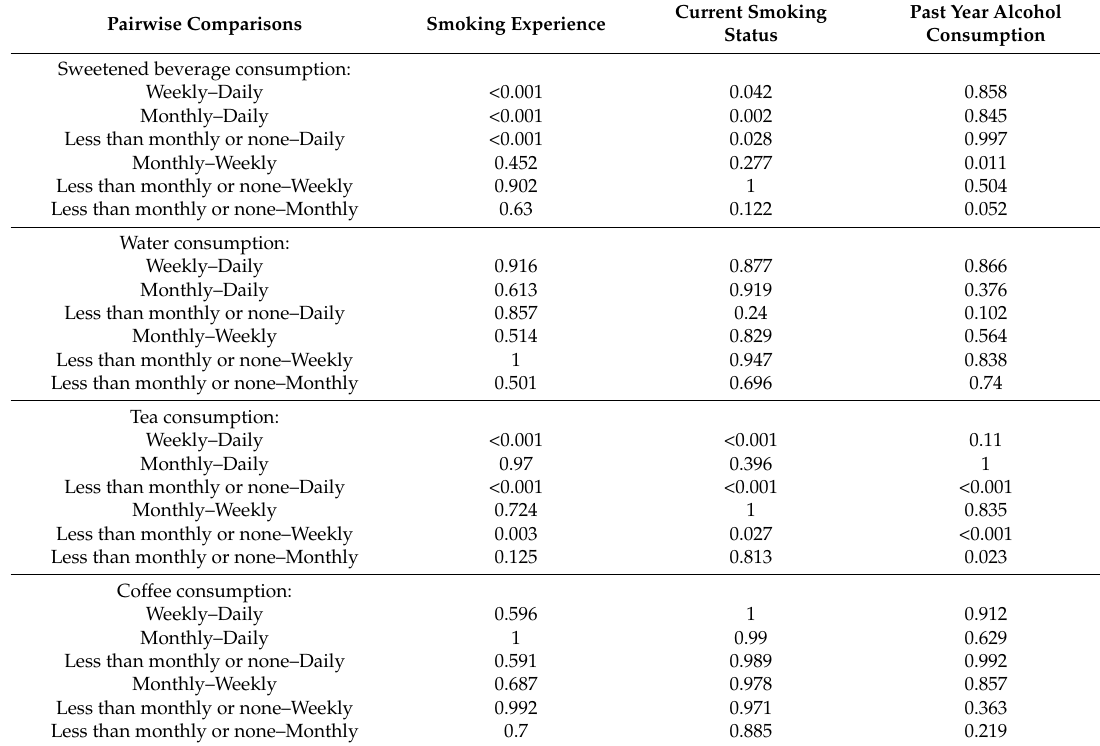
Table 3. Pairwise comparisons between each beverage intake frequency from Tukey’s Honest Significance tests. Data source: China Health and Nutrition Survey,